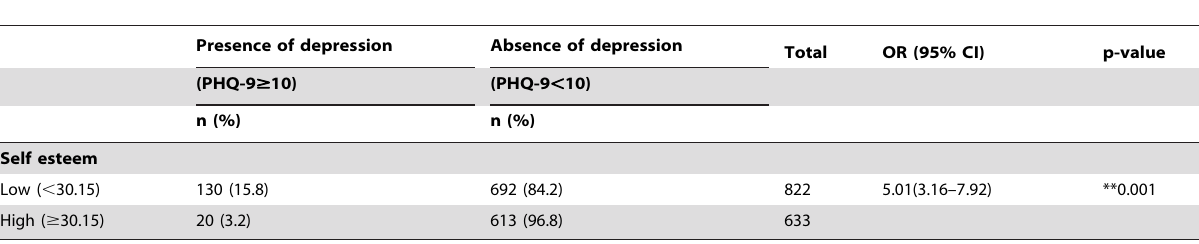
Table 7. Association of self-esteem with depression among participants (n =1455).